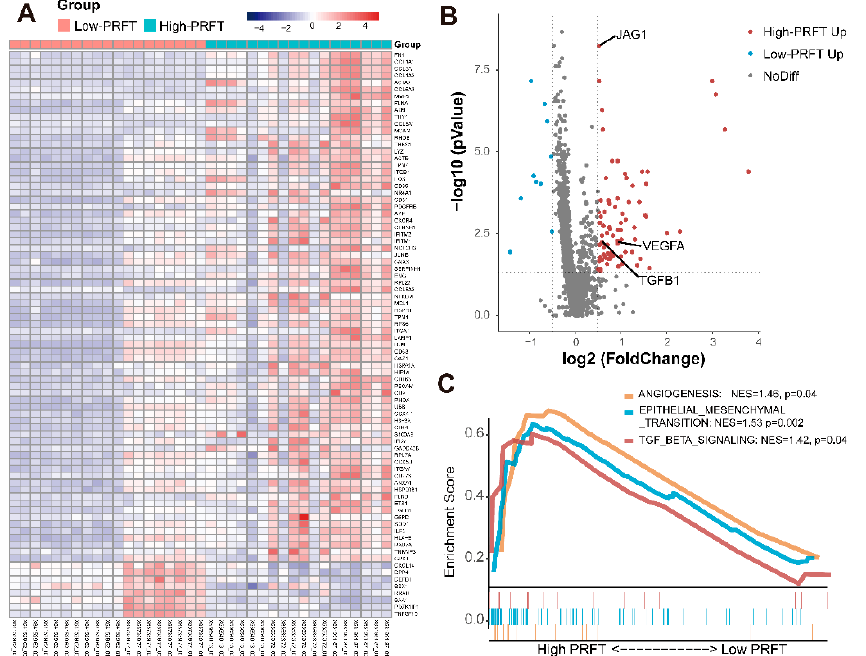
Figure 4. Gene sequencing from six patients with different PRFT. Transcriptome sequencing was performed on the RCC of six patients with different PRFT. Heat maps ( A ) and volcano figure ( B ) of differential genes was showed. GSEA analysis identified that the RCC of patients with high PRFT have increased angiogenesis gene signatures (C). GSEA: Gene Set Enrichment Analysis; PRFT: perirenal fat thickness.